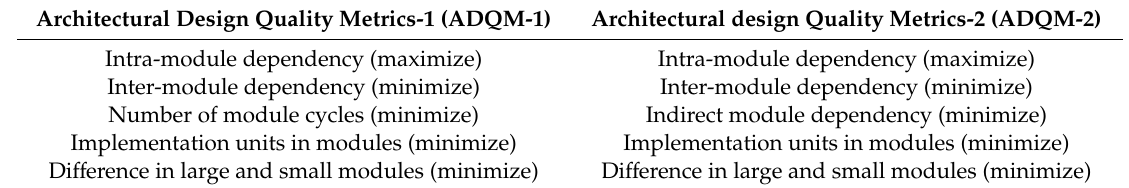
Table 1. Multi-objective formulations for module-view software architecture